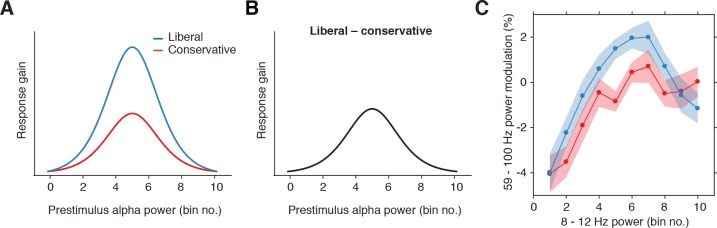
Gain model predictions and corresponding empirical data plotted as a function of pre-stimulus alpha bin number.(A) Model predictions for both conditions. The gain curve for the liberal condition is steeper than for the conservative condition. Binning trials based on alpha within each condition directly maps the peaks of the gain curves onto each other. (B) Model prediction for liberal – conservative as a function of alpha bin number. The difference gain curve between the two conditions is again an inverted-U shaped function. (C) Corresponding empirical data. The plot is identical to Figure 5C, except that the bin number is plotted instead of the actual alpha power for each condition.